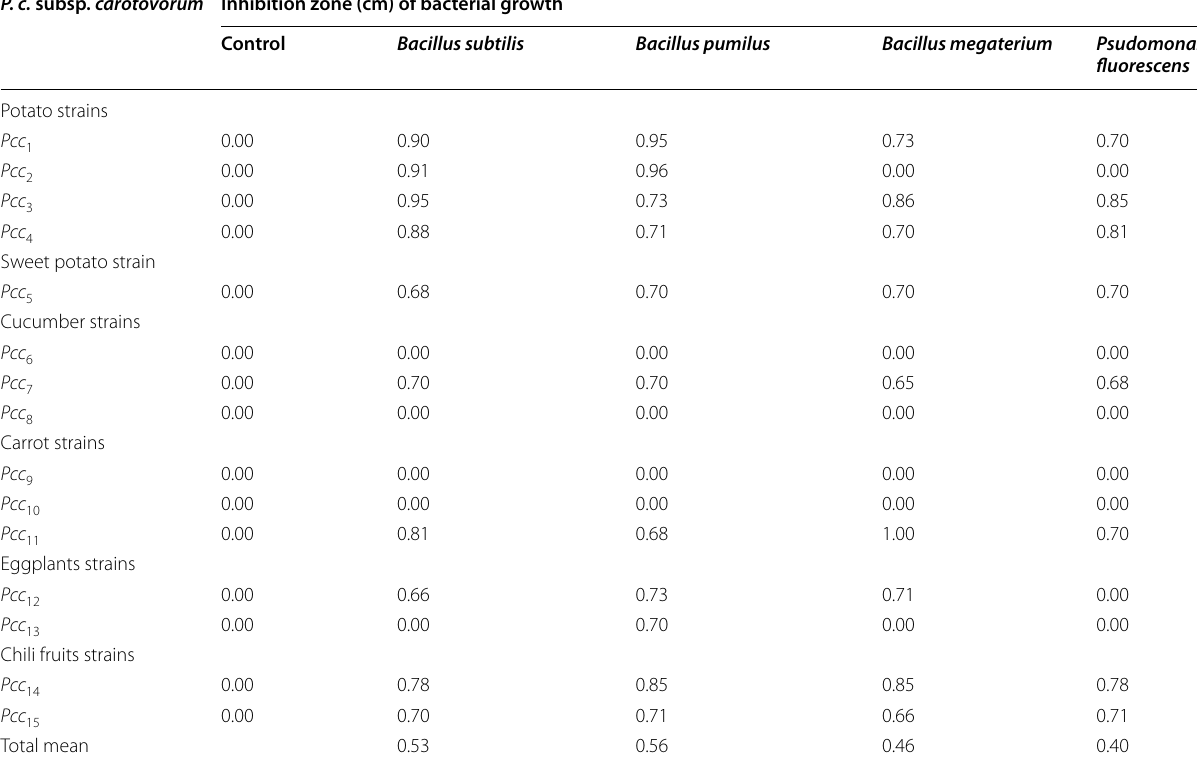
Table 2 Inhibitory activity of the crude cultural filtrates of bacterial agents against the bacterial growth of Pectobacterium carotovorum subsp. carotovorum strains in vitro